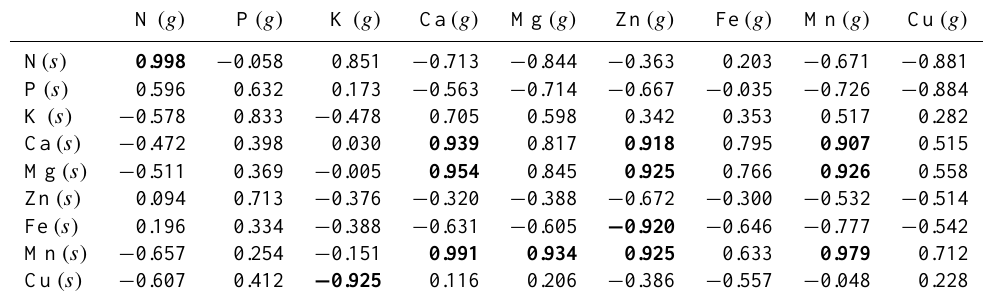
Table 8. Correlation between soil macro- and micronutrients availables and total plant amounts in D. antarctica growing on Potter